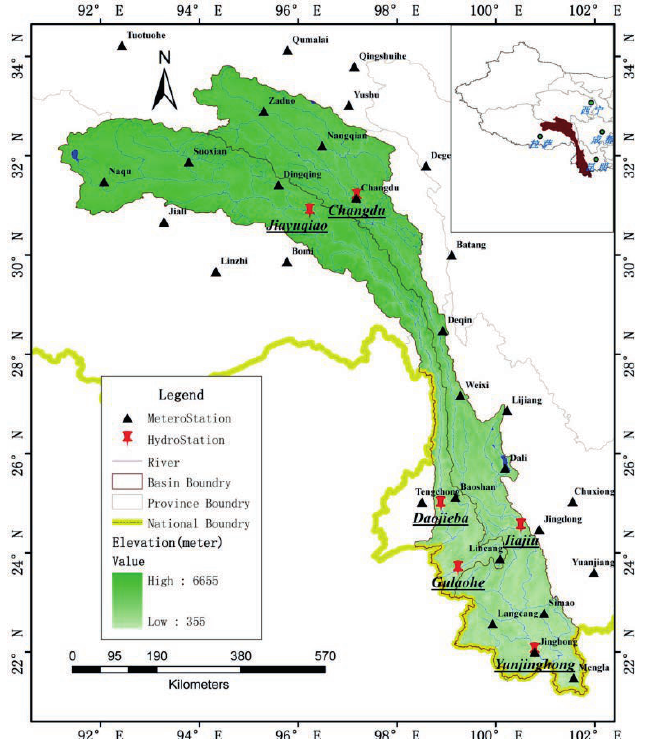
Fig. 1 Upper Salween and Mekong river basins and distribution of meteorological and hydrological